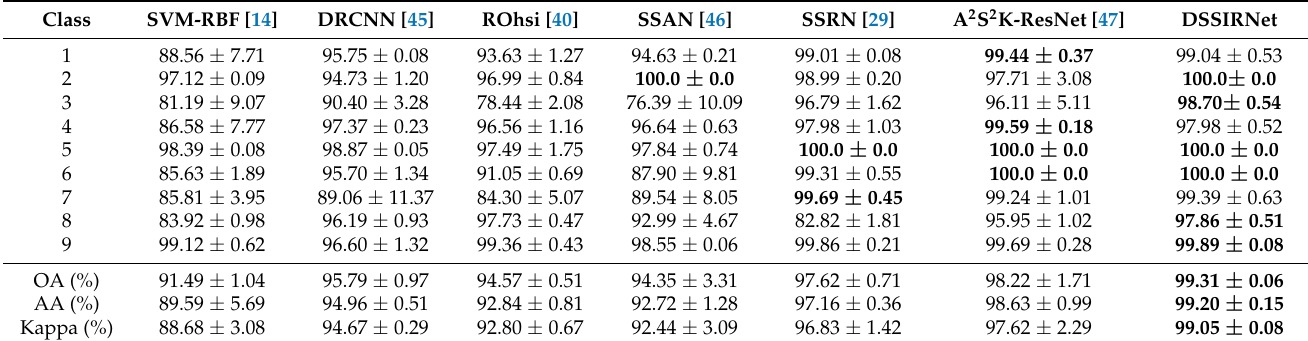
Table 4. Classification results of different methods on the UP dataset.